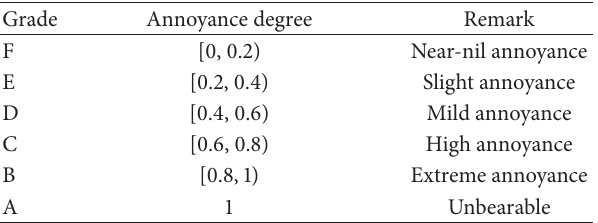
Table 2: Classification of annoyance